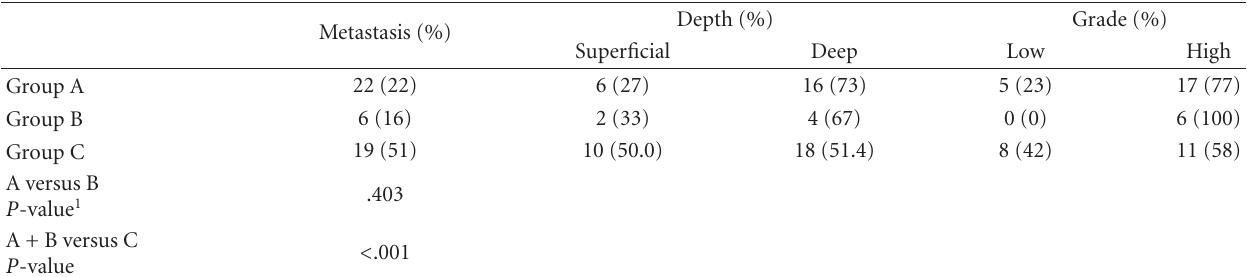
Table 3: Characteristics of the STS in the di ff erent groups according to metastasis.